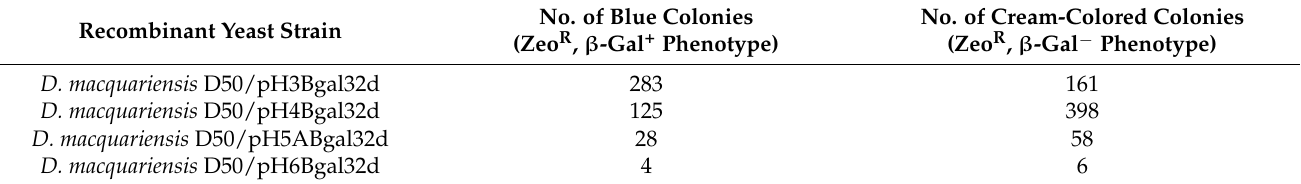
Table 4. Results of D. macquariensis D50 transformation with Bsp HI-linearized